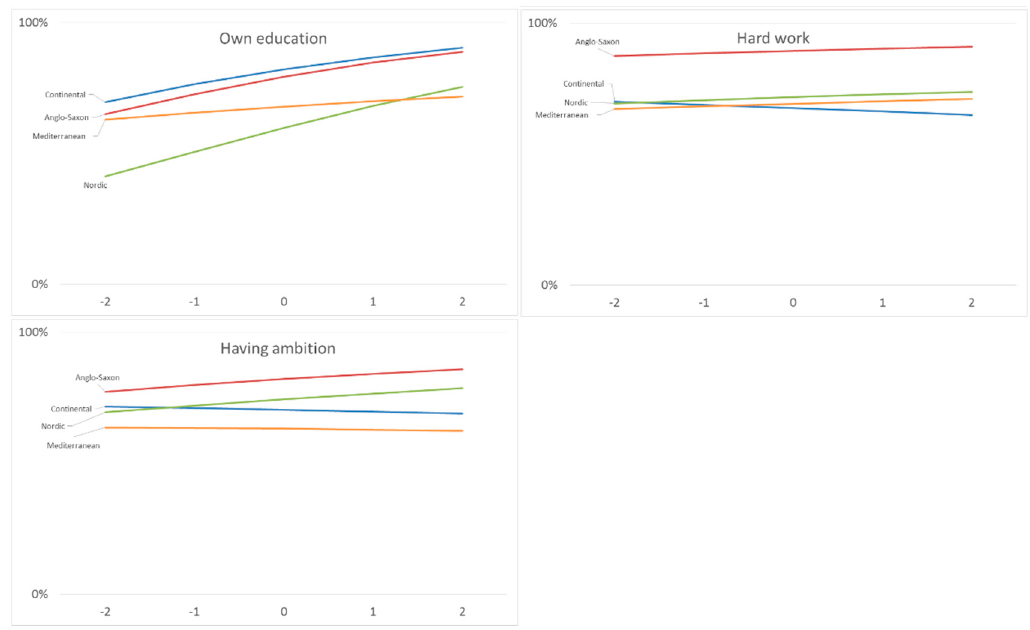
Figure 4. The importance of various assets to get ahead in life, according to educational level (standardized years of schooling).